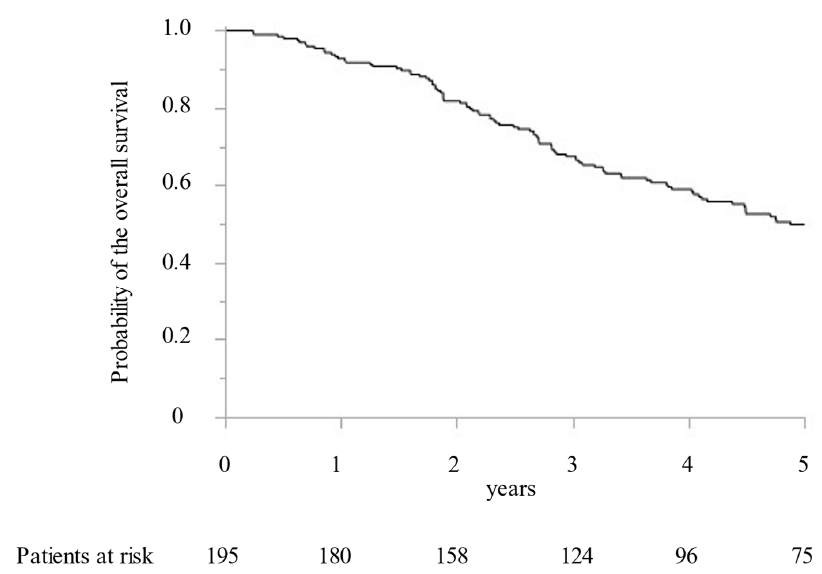
Figure 1. The Kaplan–Meier curve of the overall survival following microwave ablation.